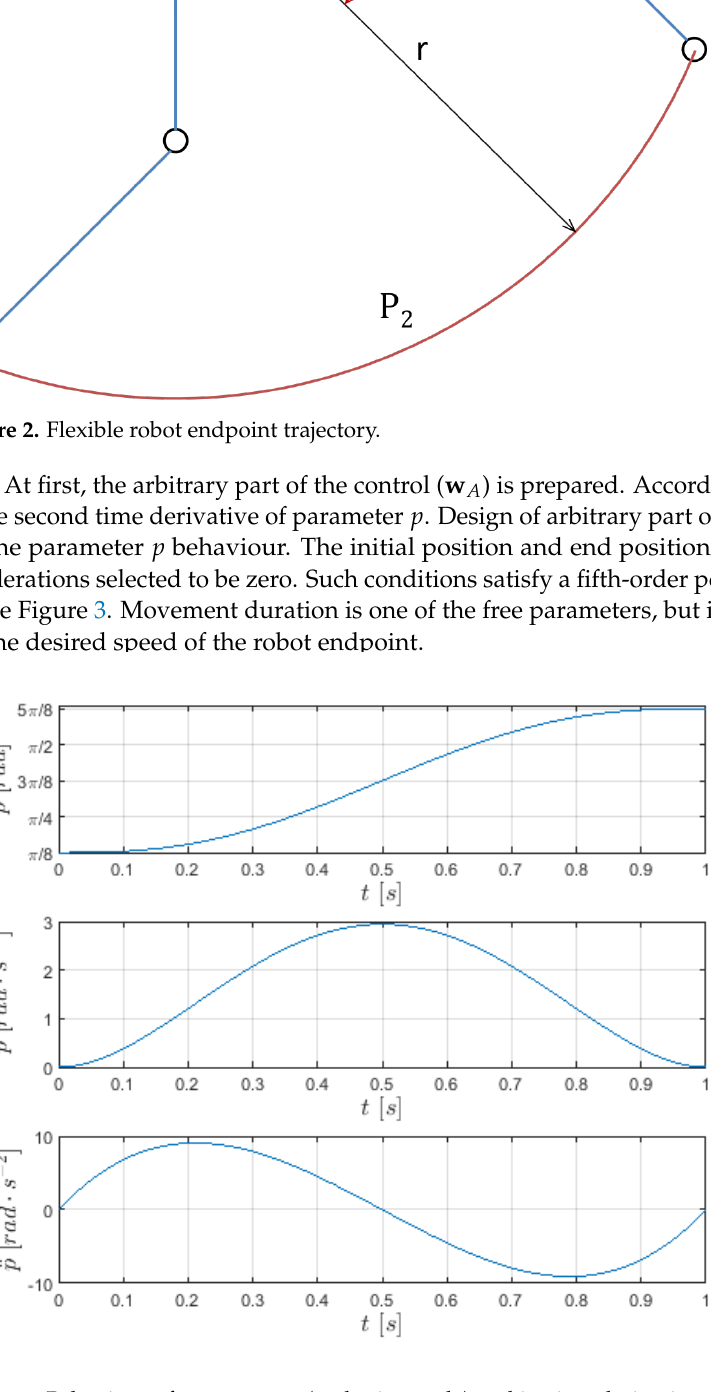
Figure 3. Behaviour of parameter p (endpoint angle) and its time derivatives ˙ p and ¨ p